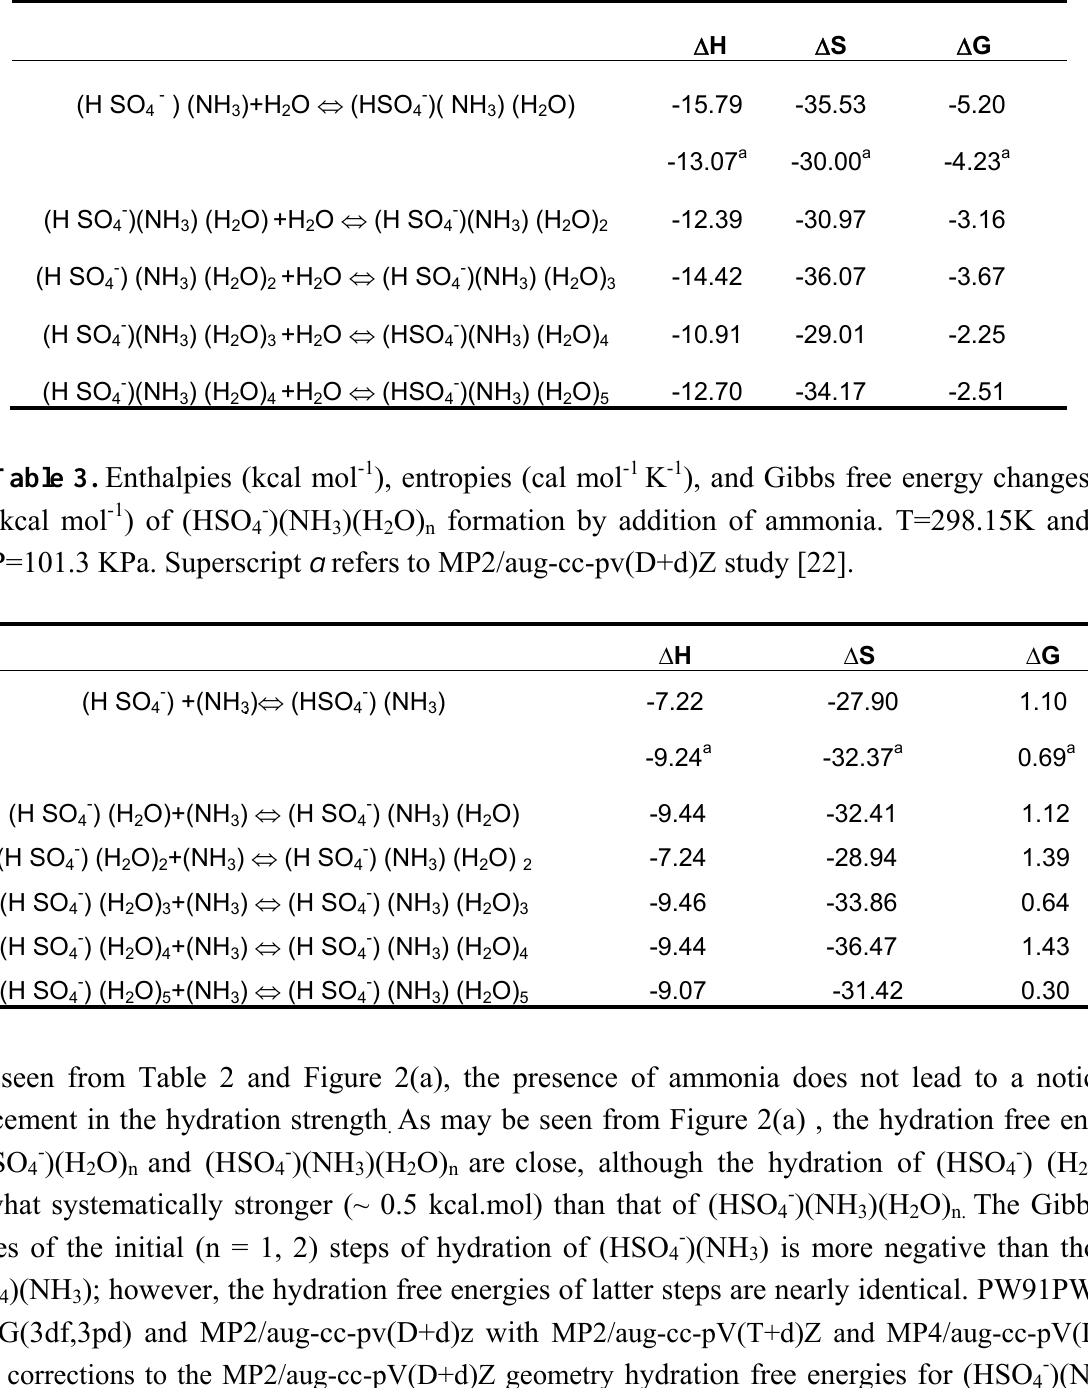
Table 2. Enthalpies (kcal mol -1 ), entropies (cal mol -1 K -1 ), and Gibbs free energy changes